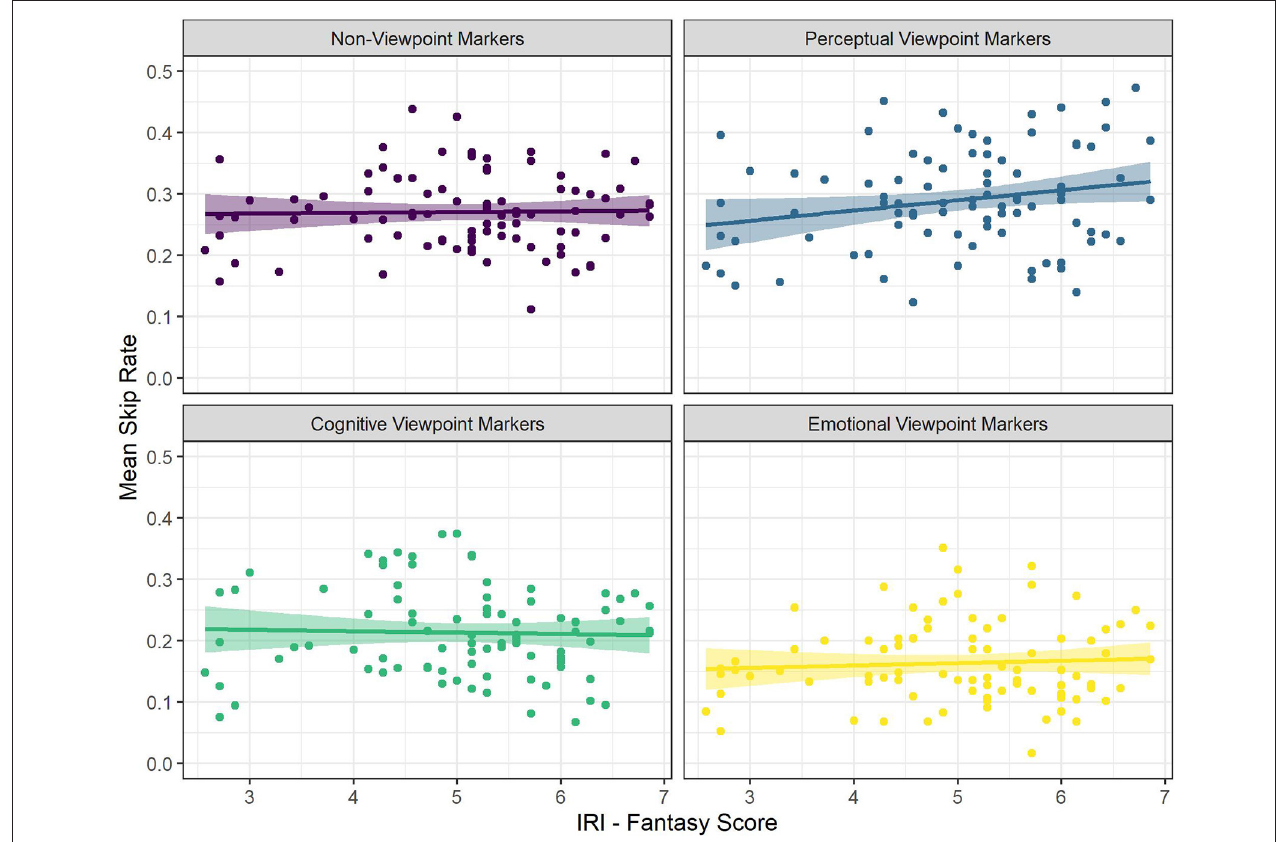
FIGURE 2 | The Relationships Between Mean Skip Rate and IRI Fantasy Score for the Different Categories of Viewpoint Markers. Each Dot Represents a Participant.